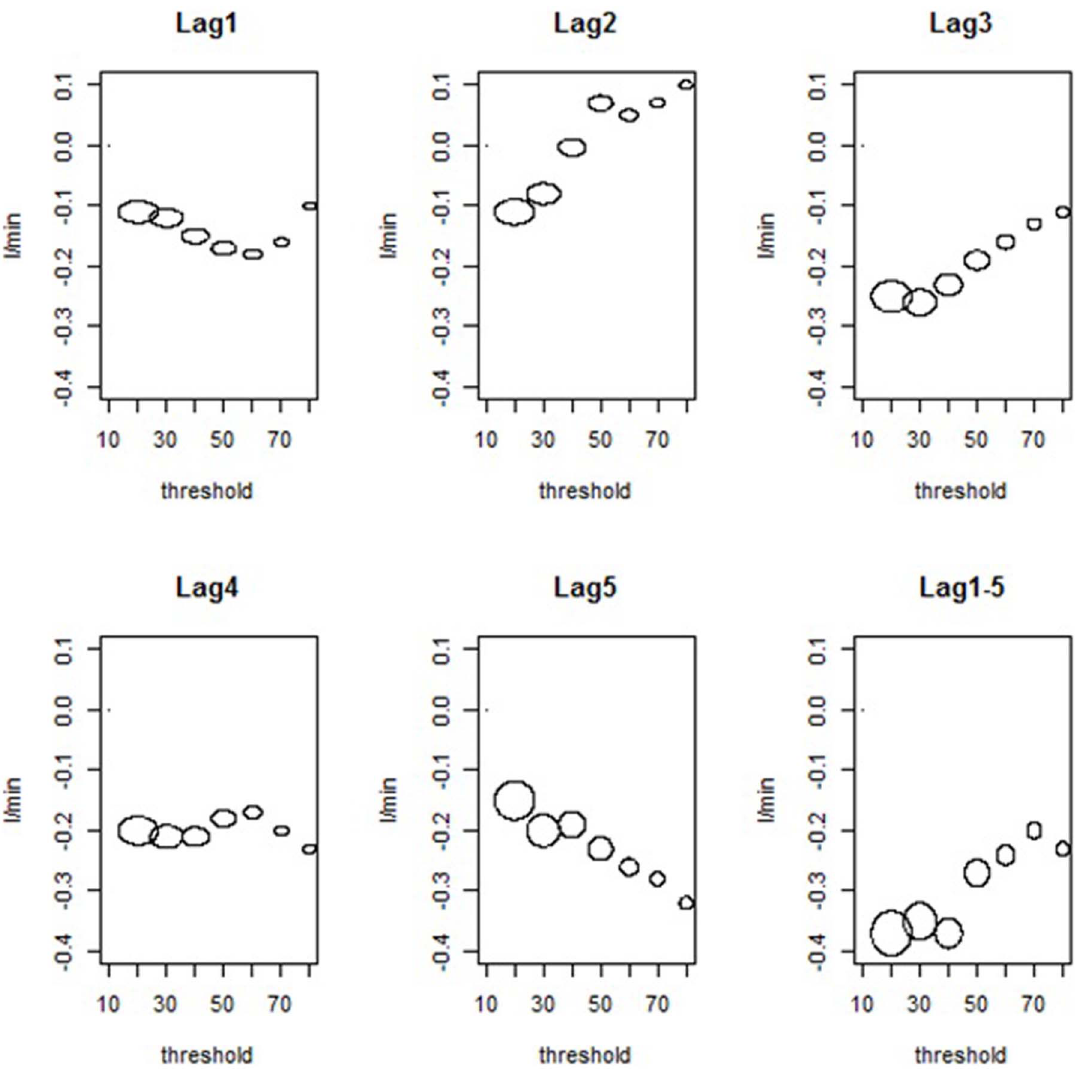
Figure 3. Estimated changes in peak expiratory flow (in l/min) for an increase of 10 m g/m 3 in PM 10 , above the thresholds for all children. Tangara´ da Serra-MT, Brazil – 2008.